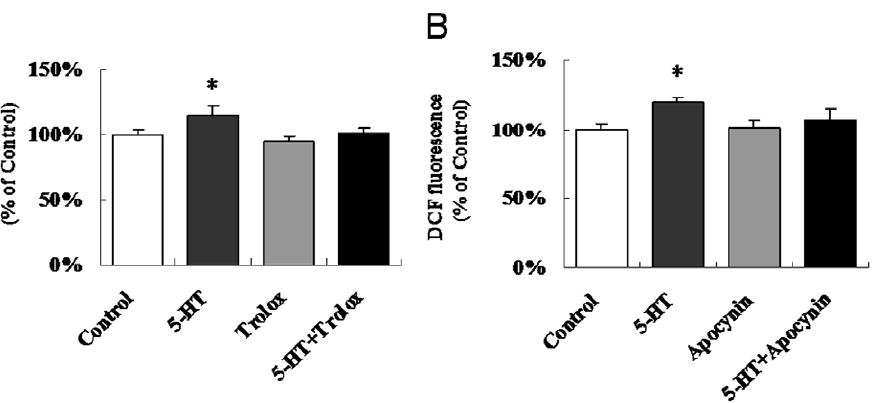
Figure 2. NADPH oxidase is required for the 5-HT-induced hypothalamic ROS elevation. The dye H 2 DCFDA was used to detect the change in the hypothalamic ROS levels. (A) ICV co-injection with 5-HT and Trolox. n=11–12 per group. (B) ICV co-injection with 5-HT and Apocynin. n=8–9 per group. Data are expressed as the means 6 SEM. *, 0.01 , p , 0.05, vs. the control.